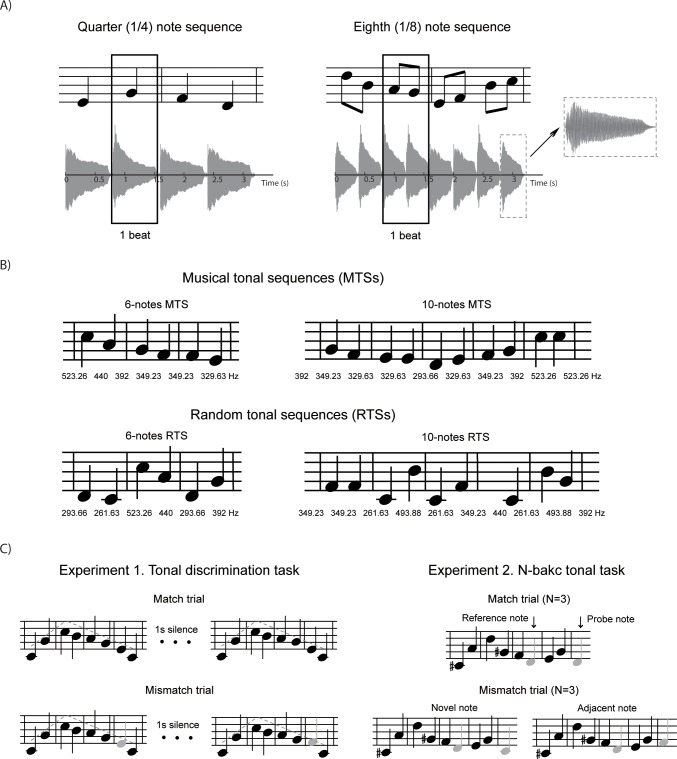
Examples of experimental stimuli and paradigm.(A) Top plots:
Examples of a quarter (1/4) note sequence (left)
and an eighth (1/8) note sequence (right) with two
measures. Bottom plots: amplitude profiles of the
note sequences shown on the top. Each measure consists of two beats,
in which one beat corresponds to one note for the quarter note
sequence and two notes for the eighth note sequence.
(B) Examples of musical tone
sequences (MTSs, top plots) and random tone
sequences (RTSs, bottom plots) with 6 notes
(left) or 10 notes (right).
(C) Examples of testing
sequence pairs. Left: Experiment 1, tonal
discrimination task. The upper row is a match trial
consisting of a pair of identical note sequences. The lower
row is an example of mismatch trial, in which a note in
the second sequence (gray note) is shifted up one semitone, but the
pitch contour (dashed line) remains the same as the first sequence.
The pitch shifts of mismatch trials happen in both directions,
upwards or downwards. Right: Experiment 2, N-back
tonal task. An example of N = 3 testing condition. The upper
row is a match trial, in which the probe note (the last
note) is the same as the reference note (the 3rd to the last note).
The lower row are mismatch novel note trials
where the probe note is different from any prior notes in the
sequence. In the mismatch adjacent note trial
(right) the probe note is the same as a note
prior to the reference note ((N+1)th note condition).